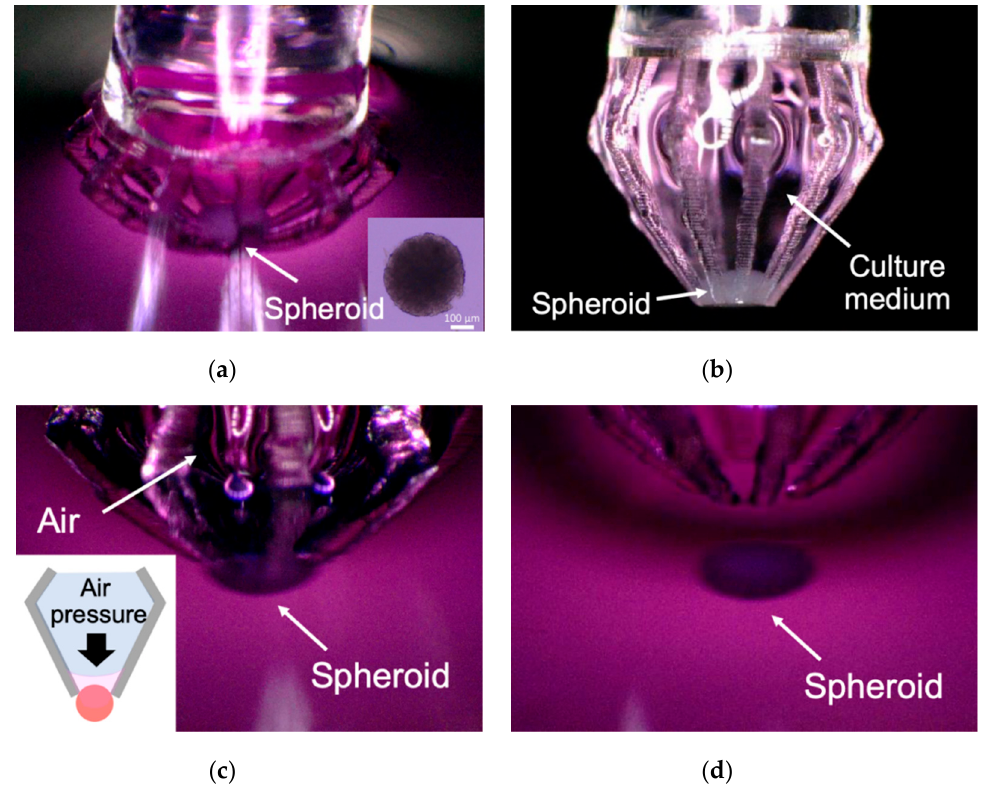
Figure 9. Demonstration of handling of a spheroid using microfingers mounted on a glass capillary: ( a ) Capturing the spheroid; ( b ) grasping the spheroid encapsulated in a culture medium; ( c ) Releasing the spheroid in a culture medium by applying air pressure; ( d ) placing the spheroid at the bottom of a dish.